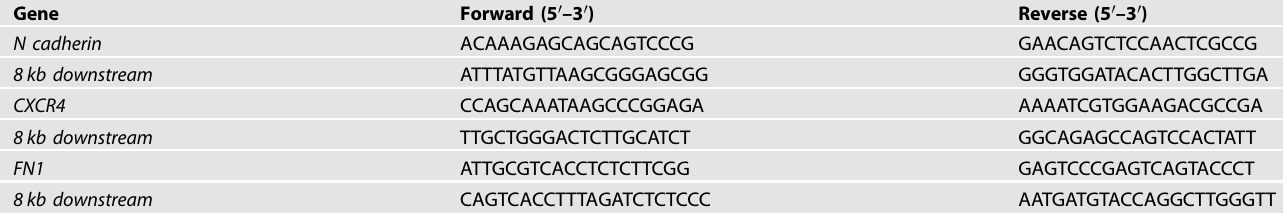
Table 3. Primer sequences of promoter